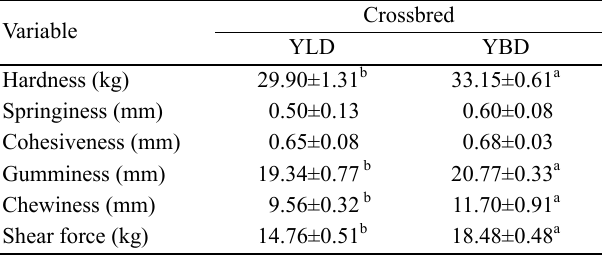
Table 3. Texture profile of dry-cured ham made from two different three-way crossbreed pigs